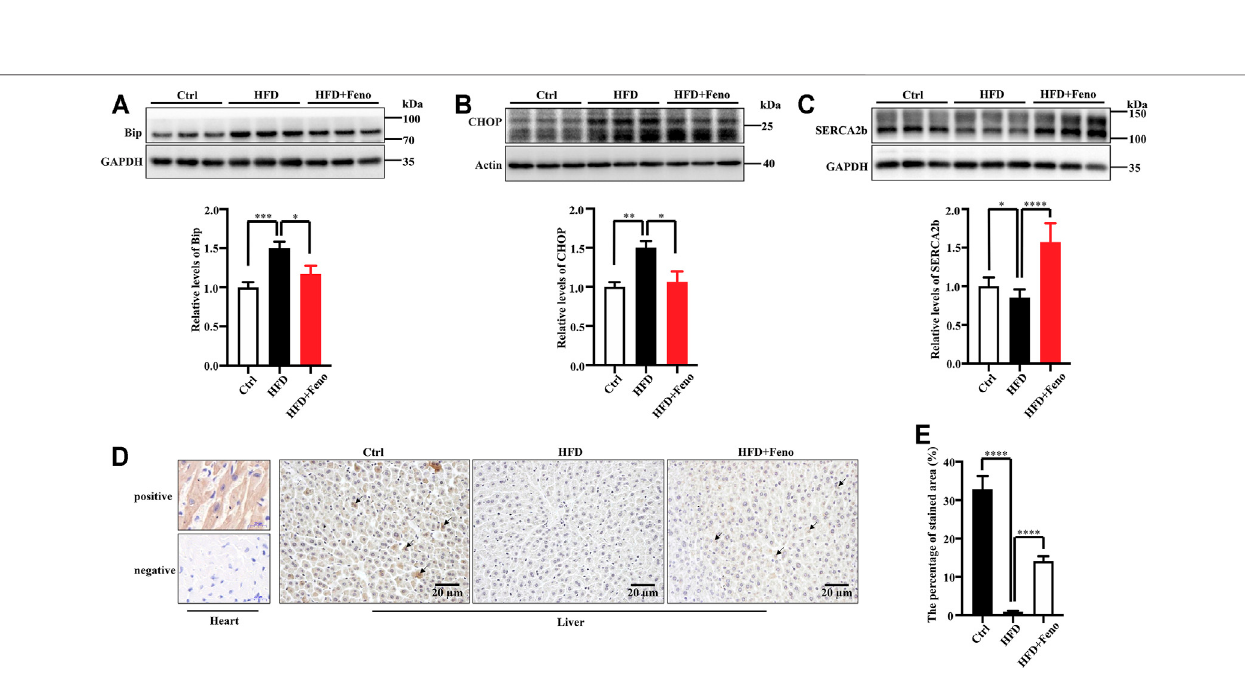
FIGURE4| Feno fi brate alleviates ERstressand elevates theexpression ofSERCA2b.Theexpression ofBip (A) ,CHOP (B) ,and SERCA2b (C) weremeasuredby western blotting. Representative western blots are shown. These results are means ± SD ( n (cid:1) 5 – 9 mice/group). * p < 0.05, ** p < 0.01, *** p < 0.001, **** p < 0.0001, HFD group versuscontrolgroup, orfeno fi brate+HFD-fed groupversusHFD group. (D) SERCA2b expression wasdetermined byimmunohistochemistry(scalebar,20 μ m); heart tissue was used as a positive and a negative control. (E) The percentage of stained area in immunohistochemistry. **** p < 0.0001, HFD group versus control group, or feno fi brate + HFD-fed group versus HFD